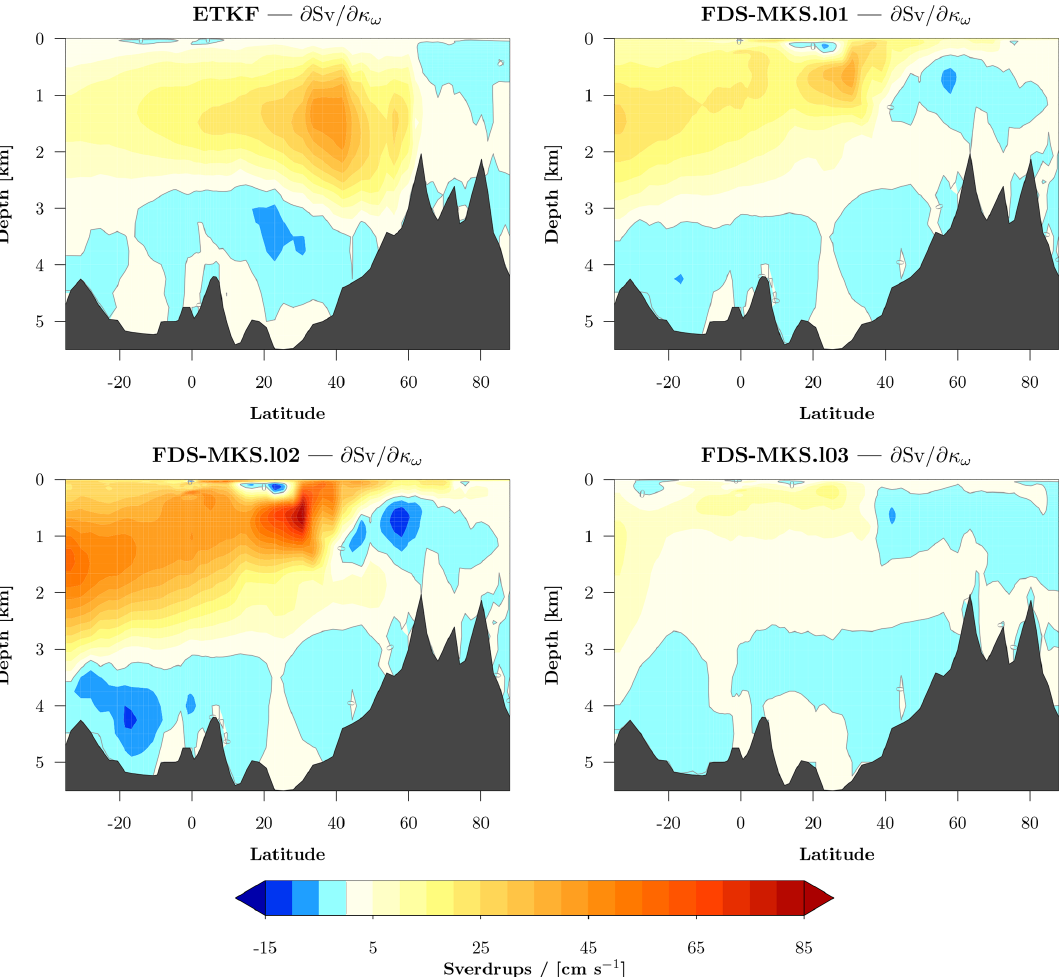
Figure 7. CESM experiment. Sensitivity of the Atlantic meridional overturning circulation (AMOC) to the ocean background vertical diffu- sion parameter ( κ ω ; POP2.bckgrnd_vdc1) in the ocean model estimated as ensemble sensitivity (from the ETKF background ensemble) and local FDS along the iterations of the three-step